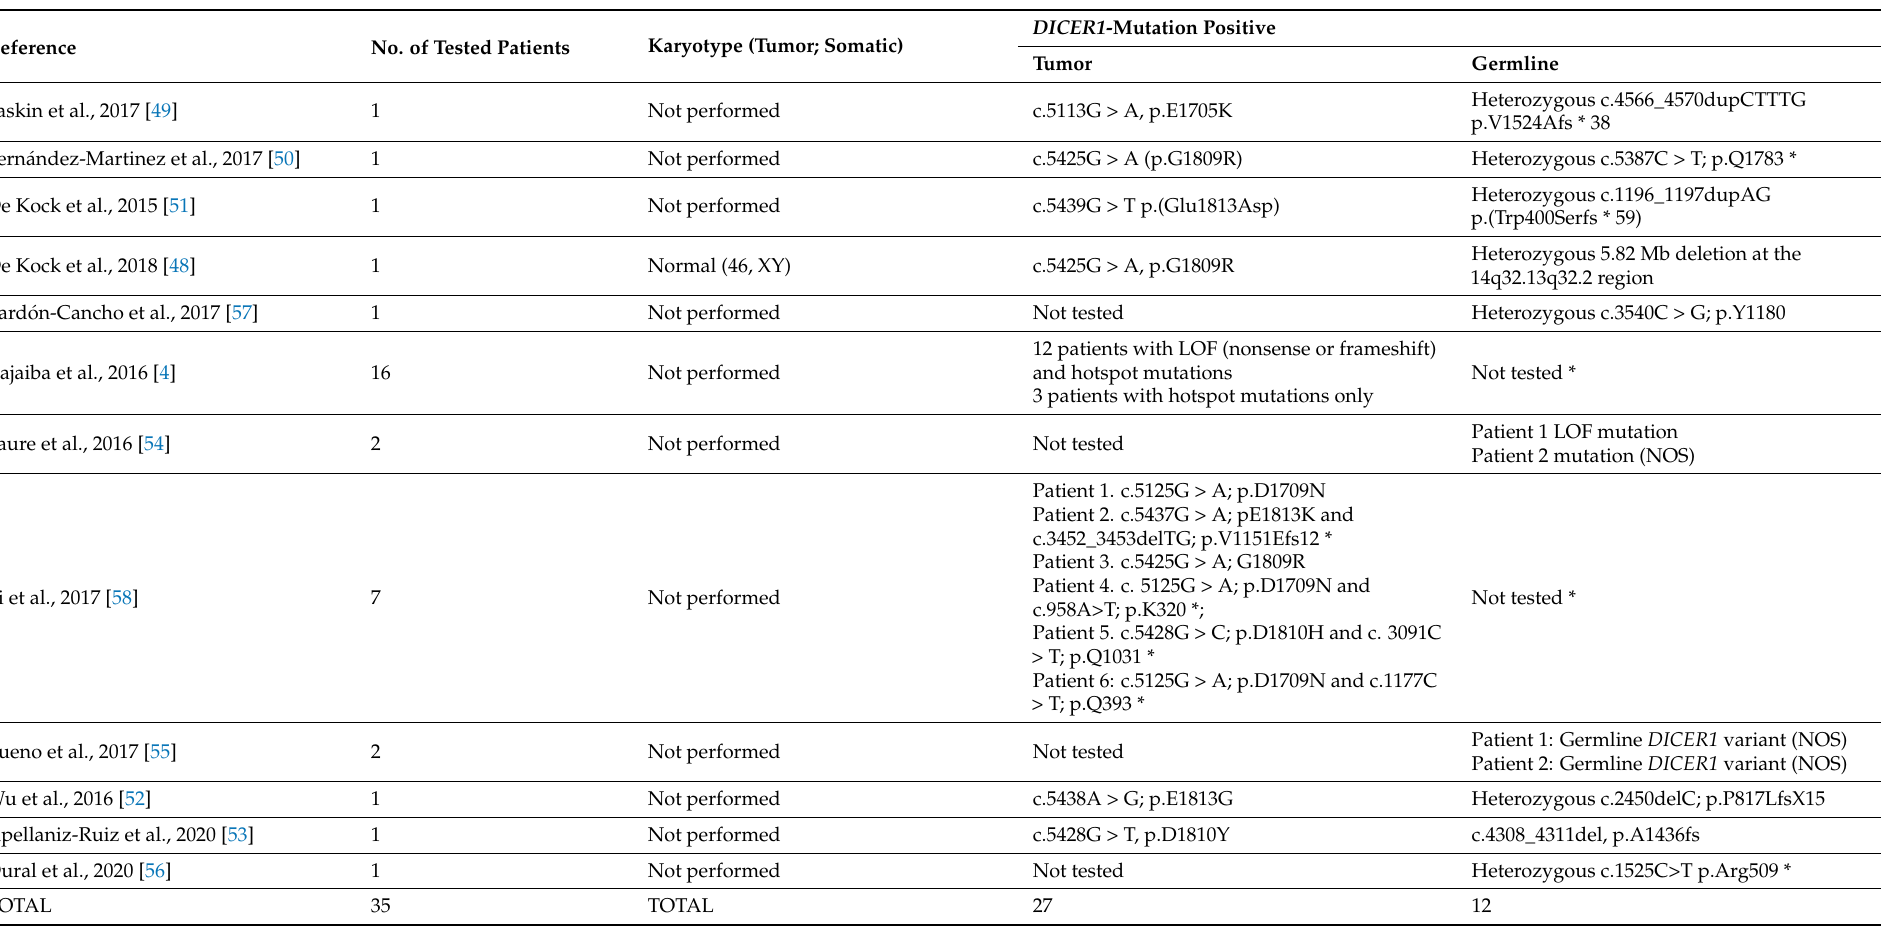
Table 5. Somatic and germline aberrations in tested CN